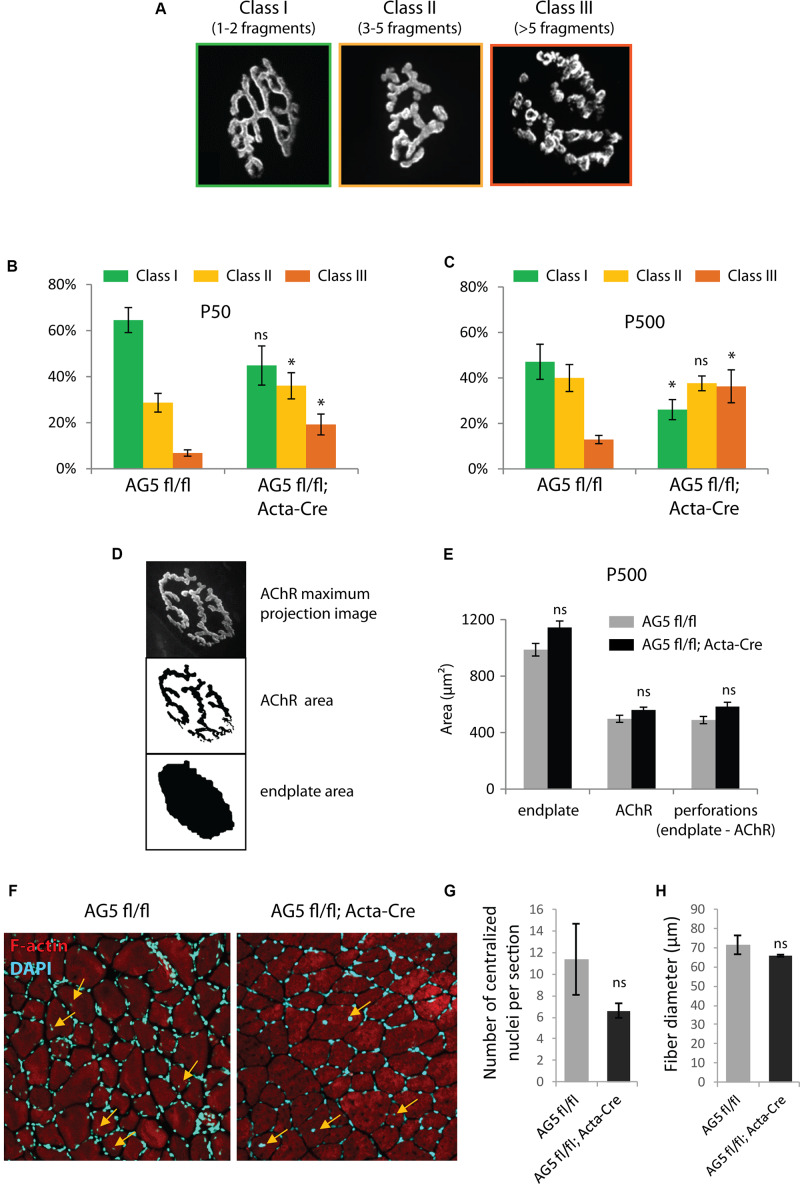
Muscle-specific loss of Arhgef5 results in progressive loss of NMJ integrity (A). Classification of NMJs according to their fragmentation. Representative examples of NMJs from each class are shown (B,C). Relative percentages of NMJs belonging to each of the three classes in tibialis anterior muscles of AG5fl/fl and AG5fl/fl; Acta-Cre mice at 50 and 500 days of age. Results are mean ± SEM of three mice from each genotype. At least 30 synapses were counted for each mouse. Arhgef5 muscle-specific knocdown causes increased fragmentation of NMJs at both ages (D). Visualization of the automated quantification of endplate and AChR areas of NMJs. The algorithm takes a maximum projection fluorescence image (top panel) and performs the segmentation of the image to calculate the AChR area (middle panel) or the total area of the endplate (bottom panel). Perforations area is calculated as the difference between endplate area and AChR area. (E) Neither the total endplate area nor the AChR area nor the perforations area were significantly different in tibialis anterior muscles of 500-day old AG5fl/fl; Acta-Cre mice compared to AG5fl/fl. Results are mean ± SEM. (F) Representative cross-sections of TA muscle of AG5fl/fl and AG5fl/fl; Acta-Cre mice. F-actin was stained with Actistain and nuclei were stained with DAPI. Centralized nuclei are indicated with arrows. (G) Quantification of centralized nuclei per TA muscle cross-section for n = 3 mice per genotype. Results are mean ± SEM. (H) Quantification of fiber diameters in TA muscle cross-sections (samples as in G). Results are mean ± SEM. ∗p < 0.05.